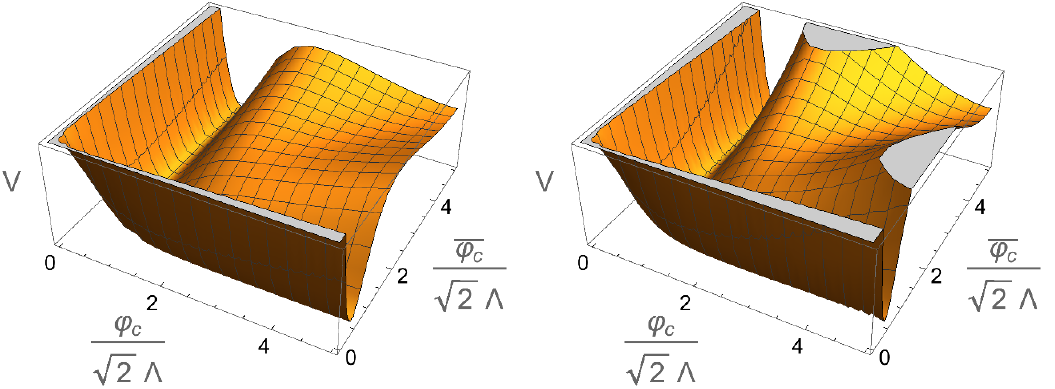
. We have taken c